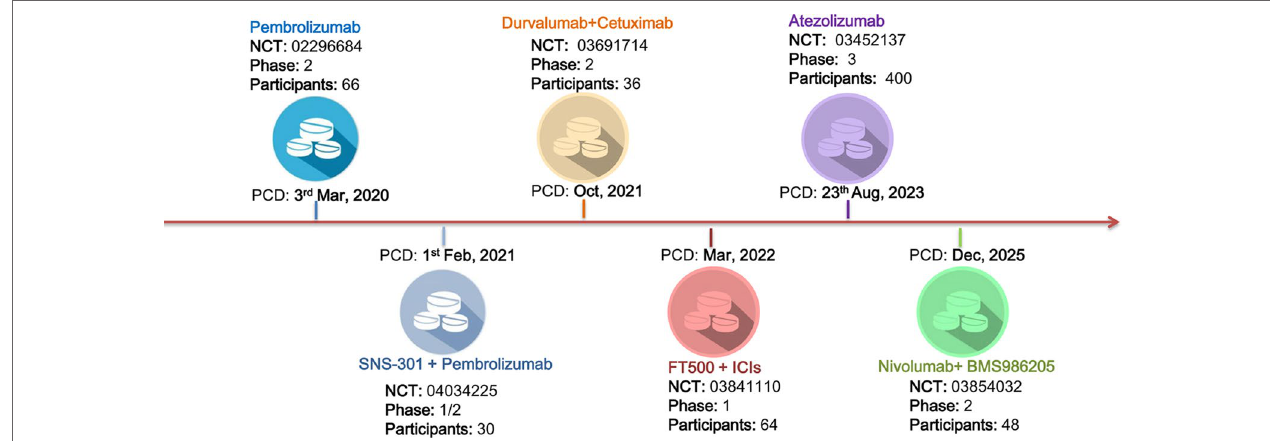
FIGURE 1 | Ongoing clinical trials for the treatment of head and neck squamous cell carcinoma (HNSCC). There were six registered ongoing trials as of August 2019. Four of them were designed in combining intervention strategy. The other two were undergoing phase 2 and phase 3 trials for Pembrolizumab and Atezolizumab in HNSCC therapy, respectively. PCD primary completion